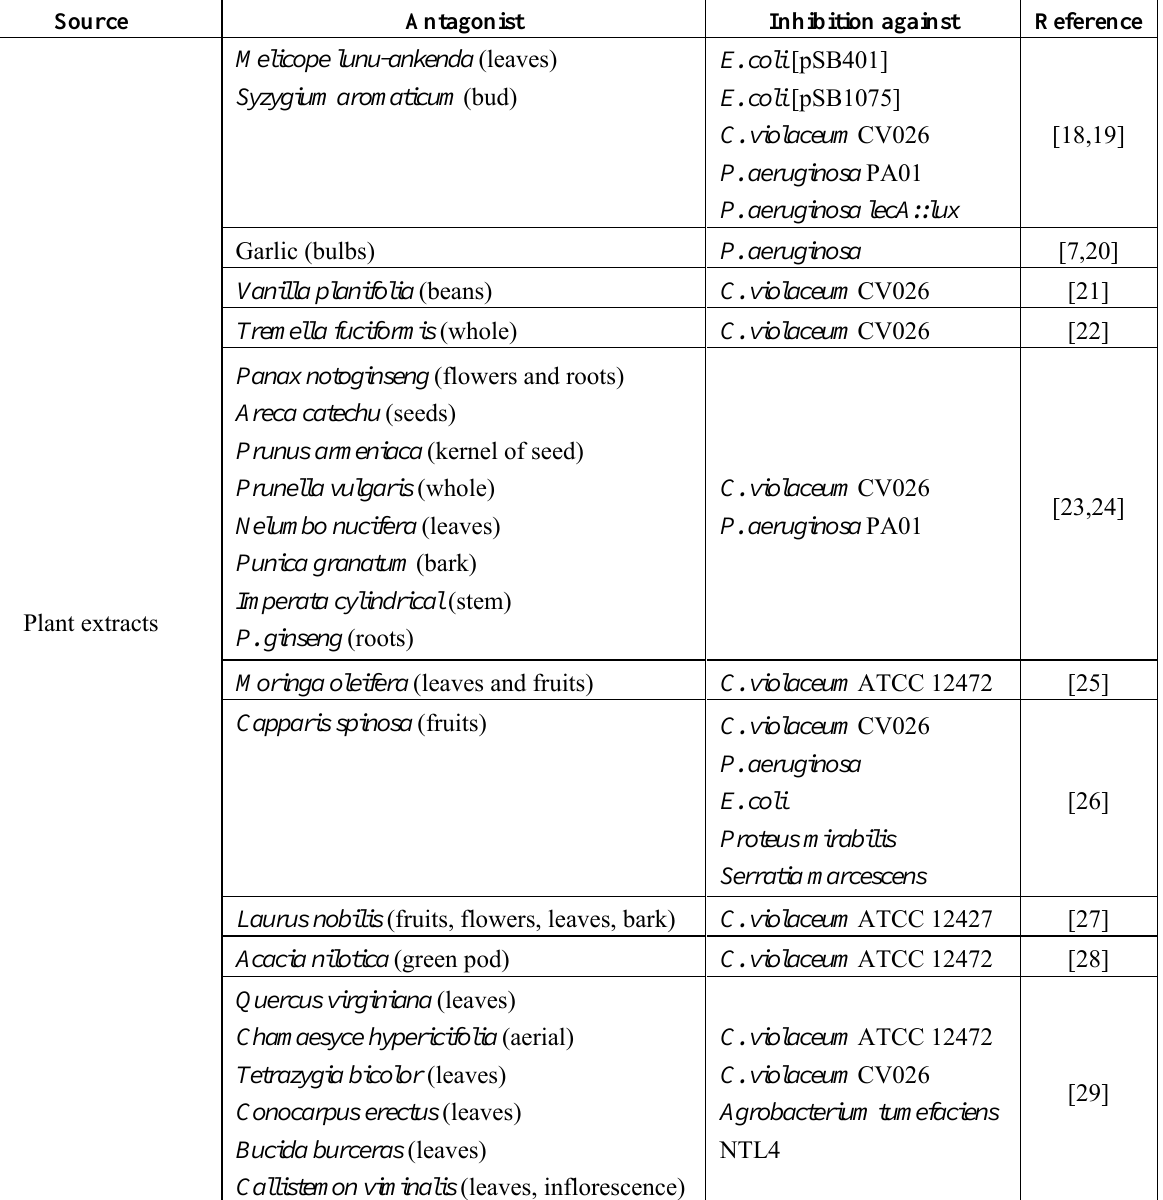
Table 1. Antagonist of QS against selected bacteria and